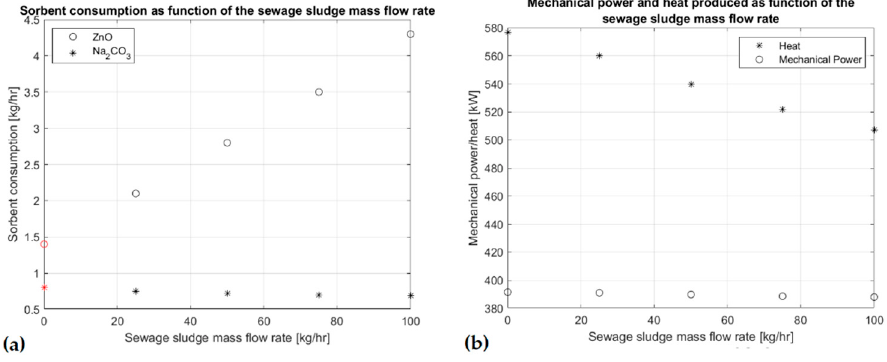
Figure 11. ( a ) Sorbent consumption as a function of sewage fraction; ( b ) mechanical power and heat recovered as a function of sewage fraction.